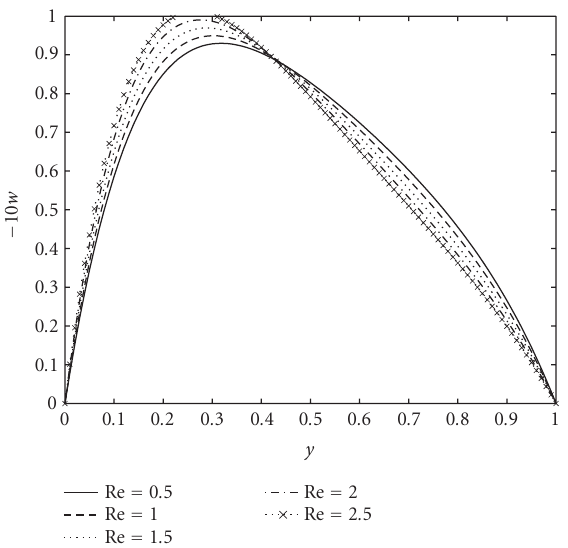
Figure 4.4. Cross-velocity − 10 w for ω = 6 . 0, S = 1 . 0, z = 0 . 5, t = 0 . 2, (cid:3) = 0 .